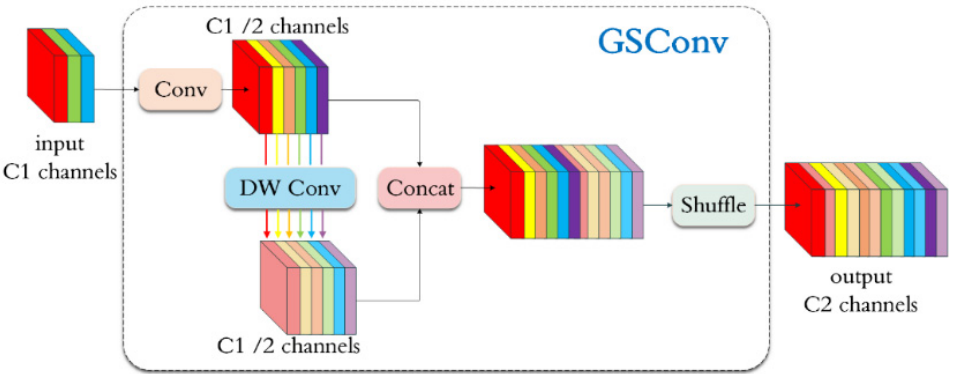
Figure 5. The structure of the GSConv. Where GSConv is the Ghost-Shuffle Convolution; DW Conv is the Depth Wise Convolution; C1 is the number of channels of the input feature map; C2 is the number of channels of the output feature map.